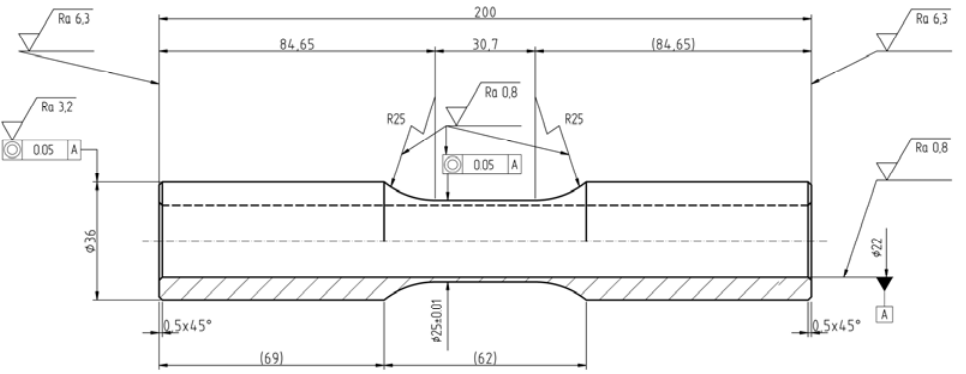
Figure 1. Technical drawing of thin-walled tubular TS.